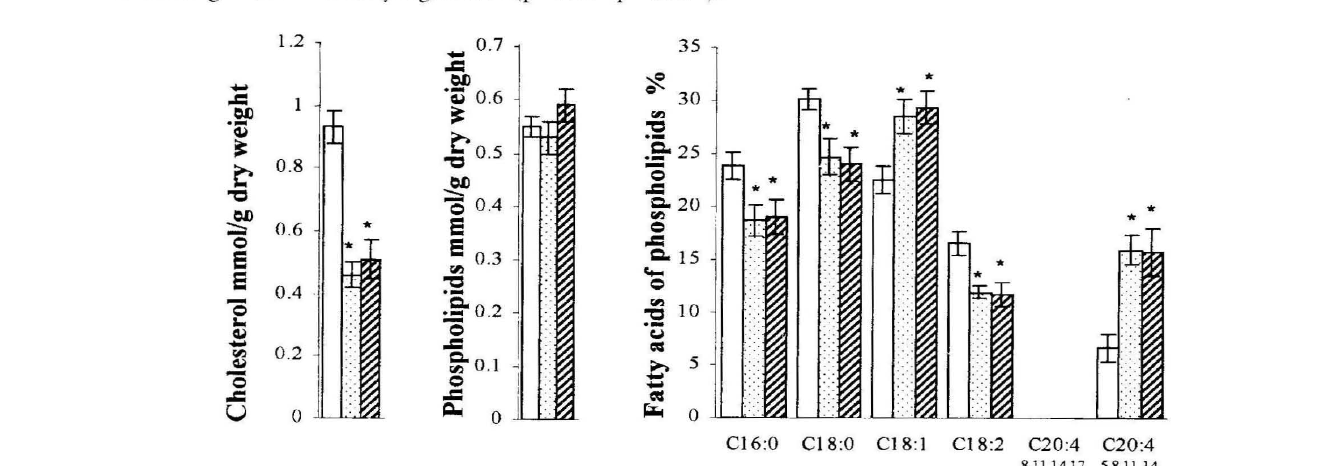
Figure 4. Concentrations (mean±S.D .) of cholesterol and phospholipids as well as fatty acid content of phospholipids (in percent; mean±S.D.) in controls (open bars) and in samples with 0.2 nmoljg wet weight picolinic acid (dotted bars) and in samples with 2 nmoljg wet weight picolinic acid (hatched bars). Samples pf rat liver tissue homogenates were used to test for phospholipid biosynthesis in vitro. Incubation medium: Krebs - Ringer - phosphate buffer containing 0 .3% albumin (pH= 7.4), fatty acid mixture and glycerol. Samples were incubated rwice fo r 4 h at 37'C. *The changes are statistically significant (p<0.05 -p< O.OOI ).